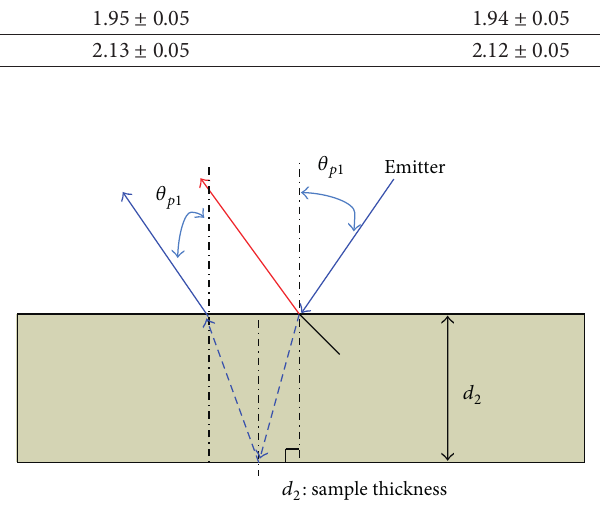
Figure 3: Diagram showing the geometry of the surface reflection mode.